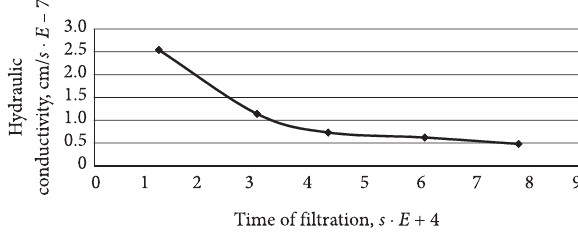
Fig. 9. Time variations in intensity of evaporation directly from the water surface in open-ended hydraulic head piezometer, as recalculated into the hydraulic conductivity corresponding to the evaporation